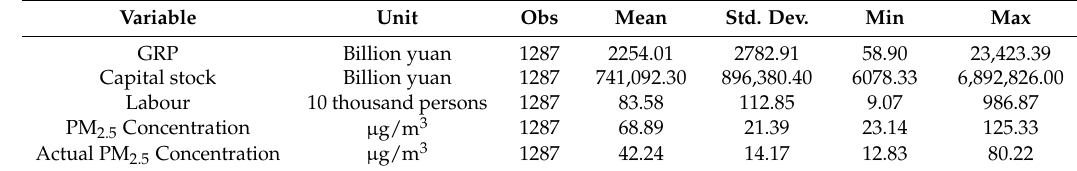
Table 3. Descriptive statistics for each variable of China’s ten major city